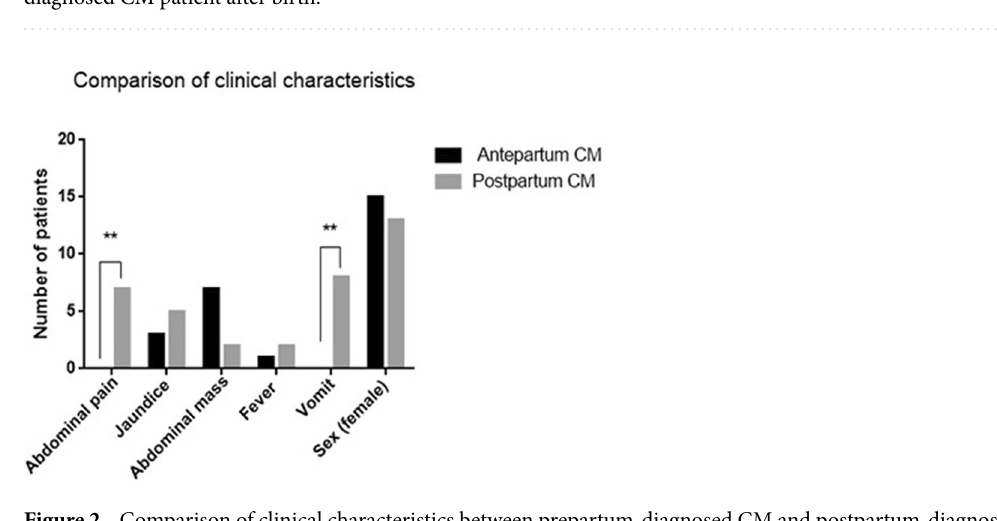
(128.61 ± 214.24 U/L, 386.21 ± 679.76 U/L, and 27.606 ± 39.786 U/L, respectively) (p < 0.05). Liver function abnormalities were more common in the postnatally diagnosed group (Figs. 3, 4, and 5).